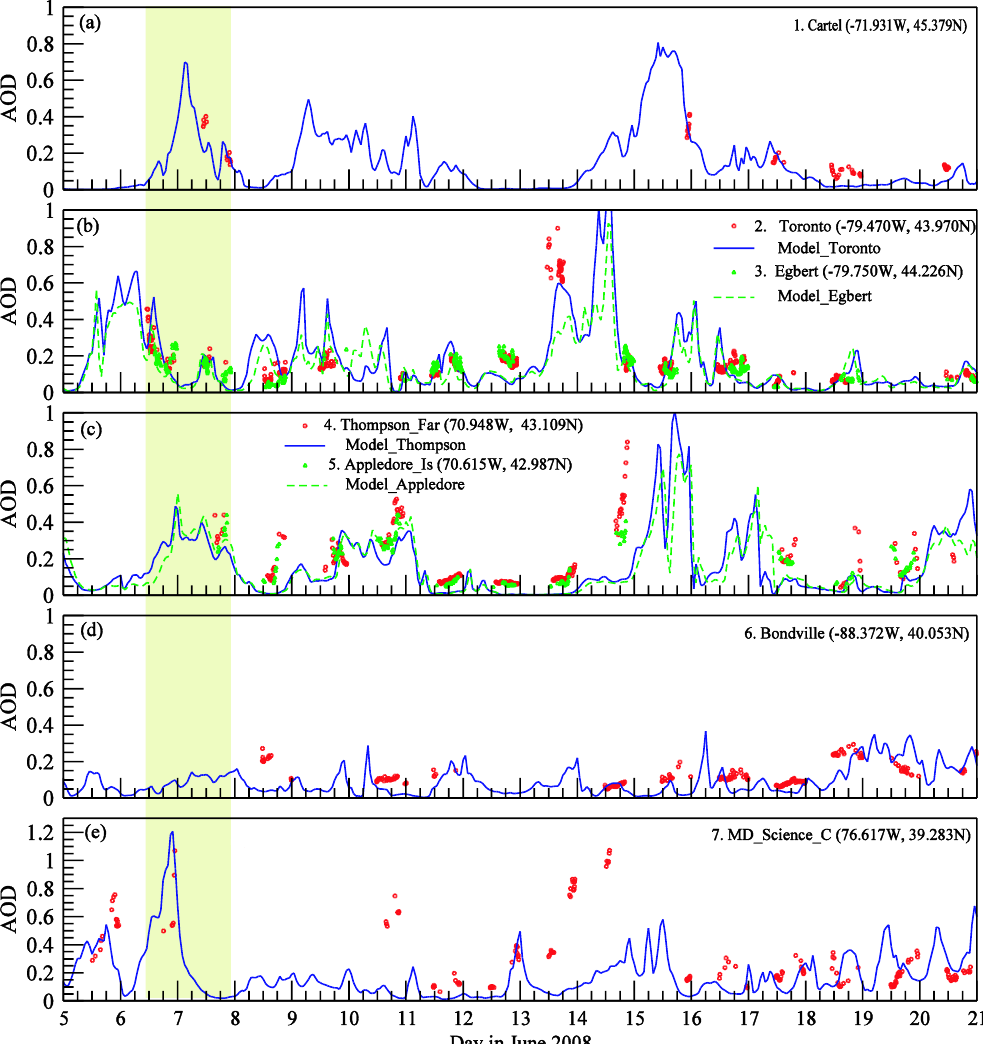
Fig. 8. Simulated and observed AOD at seven AERONET sites in northeast US during the period of 5–21 June 2008. The locations of sites are marked in Figs. 9–10. A two day period (6–7 June) used for detailed analysis is